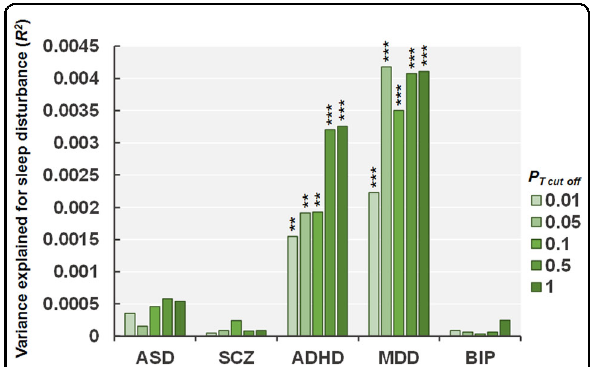
Fig. 1 Effects of polygenic risk scores (PRSs) for psychiatric and neurodevelopmental disorders. Effects of polygenic risk scores (PRSs) for psychiatric and neurodevelopmental disorders (ASD, SCZ, ADHD, MDD, and BIP) at each threshold ( P T cutoff ) on the risk of sleep disturbance in early adolescence in children of European ancestry. The y -axis represents the adjusted R 2 , indicating the explanatory power of the model. ASD, autism spectrum disorder; SCZ, schizophrenia; ADHD, attention-de fi cit/hyperactivity disorder; MDD, major depressive disorder; BIP, bipolar disorder. *** p < 0.001, ** p < 0.01, * p <